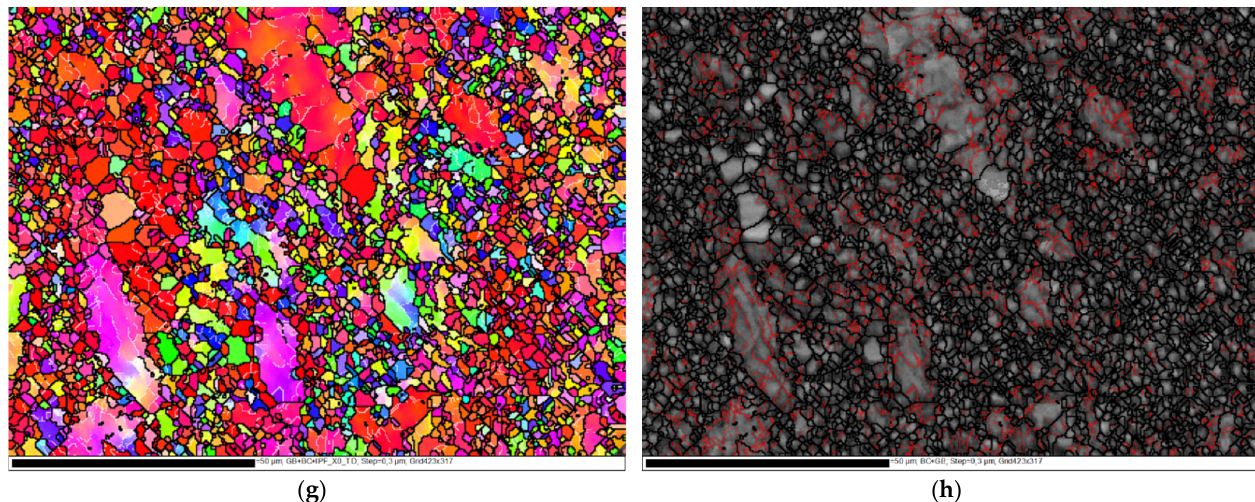
Figure 4. IPF coloring maps relative to ND and their corresponding BC maps with HAGBs in black lines and LAGBs in white lines (AA and 1-P) and red lines (2-Bc and 4-Bc), superimposed for the AA ZK30 billets ( a , b ), and ECAPed billets through ( c , d ) 1-P, ( e , f ) 2-Bc, and ( g , h ) 4-Bc.